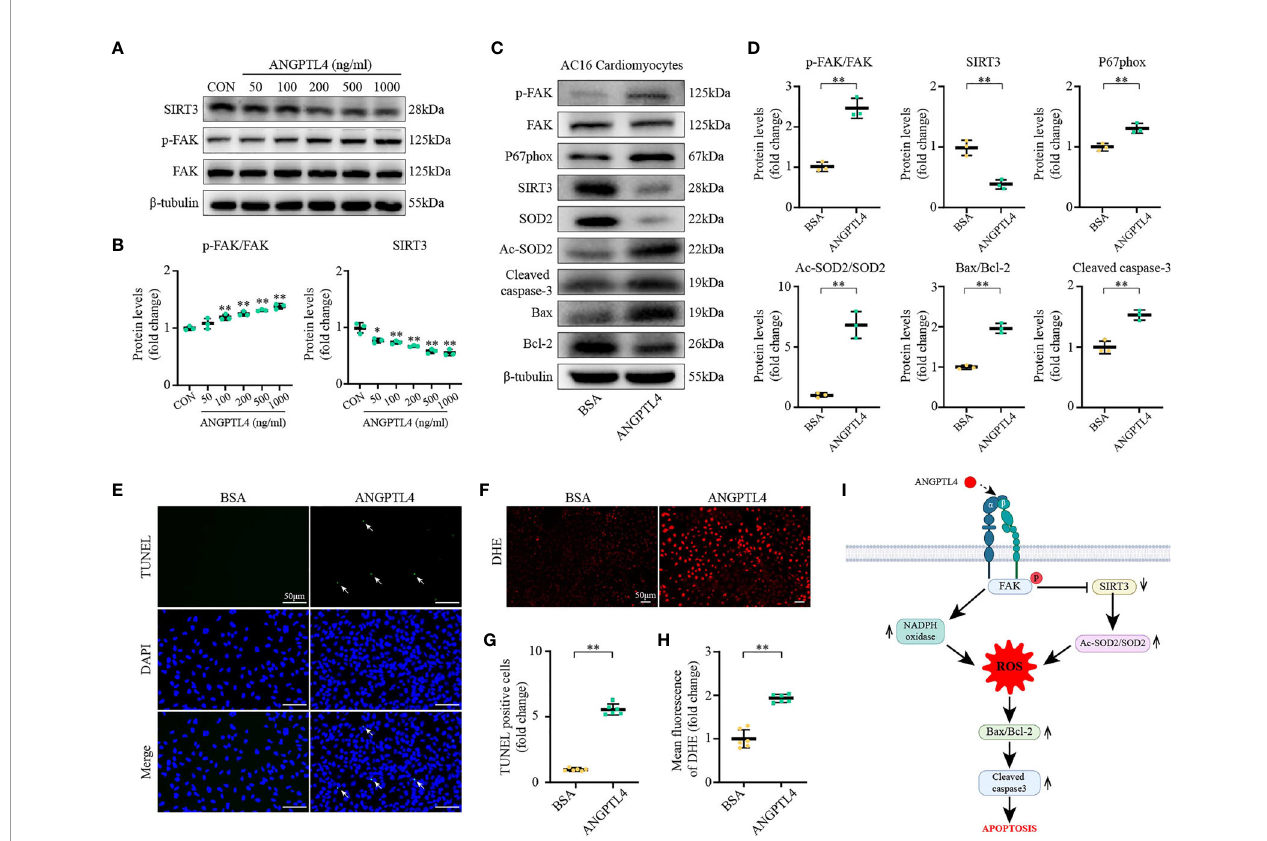
FIGURE 8 | ANGPTL4 elevated SOD2 acetylation, oxidative stress, and apoptosis. (A, B) Representative immunoblots showing SIRT3, p-FAK(Y397), and FAK levels in AC16 cardiomyocytes at 48 h after different concentrations of ANGPTL4 treatment. (C, D) Representative Western blots and quanti fi cation of p-FAK(Y397), FAK, P67phox, SIRT3, SOD2,Ac-SOD2, Bax, Bcl-2, and Cleaved caspase-3 in AC16 cardiomyocytes after treatment with BSA or ANGPTL4 (200 ng/ml each) for 48 h. (E, G) Representative images of apoptotic cardiomyocytes (200×) after treatment with BSA or ANGPTL4 (200 ng/ml each) for 48 h and percentage of TUNEL positive cells. The apoptotic cells were detected by TUNEL (green), and the nuclei were detected by DAPI (blue). Scale bar, 50 m m. (F, H) Representative images and quanti fi cation of DHE fl uorescence in AC16 cardiomyocytes after treatment with BSA or ANGPTL4 (200 ng/ml) for 48 h. Scale bar, 50 m m. (I) Schematic illustration shows ANGPTL4 interacting with integrin, inducing apoptosis in the Diabetic Cardiomyopathy via FAK/SIRT3/ROS pathway in cardiomyocyte. P represents phosphorylation, a and b represent subunit of the integrin. Data are shown as mean ± SD; * p < 0.05, ** p < 0.01 vs BSA group (student t